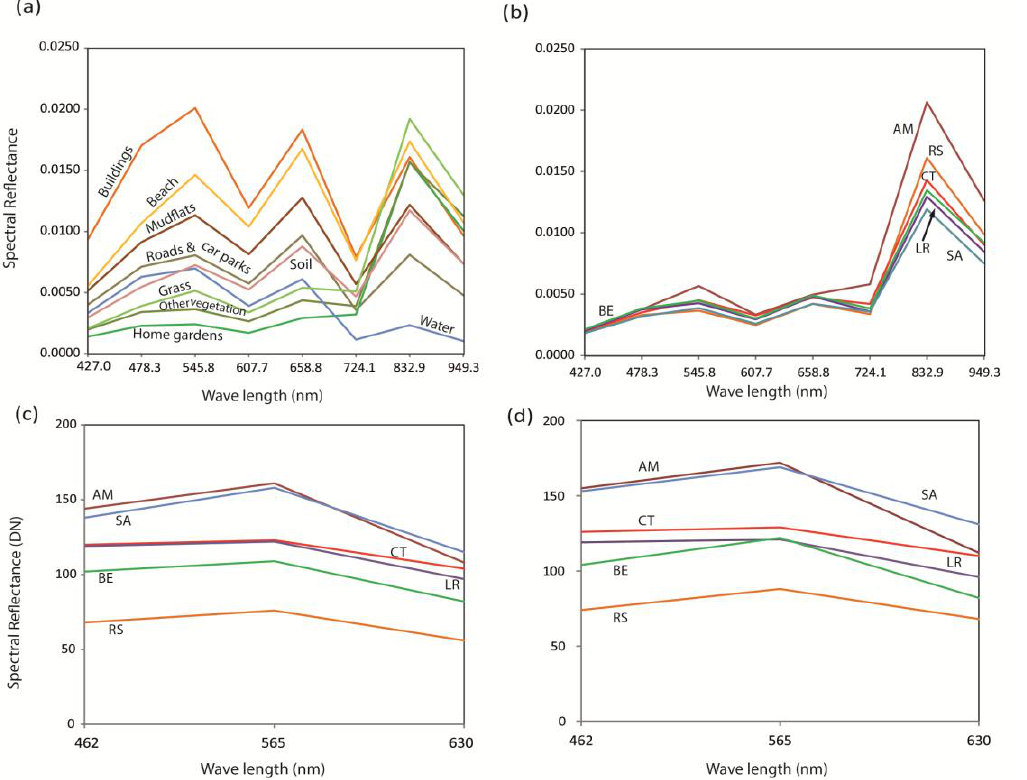
Figure 4. Spectral profiles of: (a) all features except mangroves extracted from WV2 image; (b) mangrove species only extracted from WV2 image; (c) mangrove species extracted from aerial photographs of spatial resolution 0.14 m; and (d) mangrove species extracted from aerial photographs of spatial resolution 0.5 m. (AM- Avicennia marina , CT- Ceriops tagal , BE- Bruguiera exaristata , LR - Lumnitzera racemosa , RS- Rhizophora stylosa , SA- Sonneratia alba